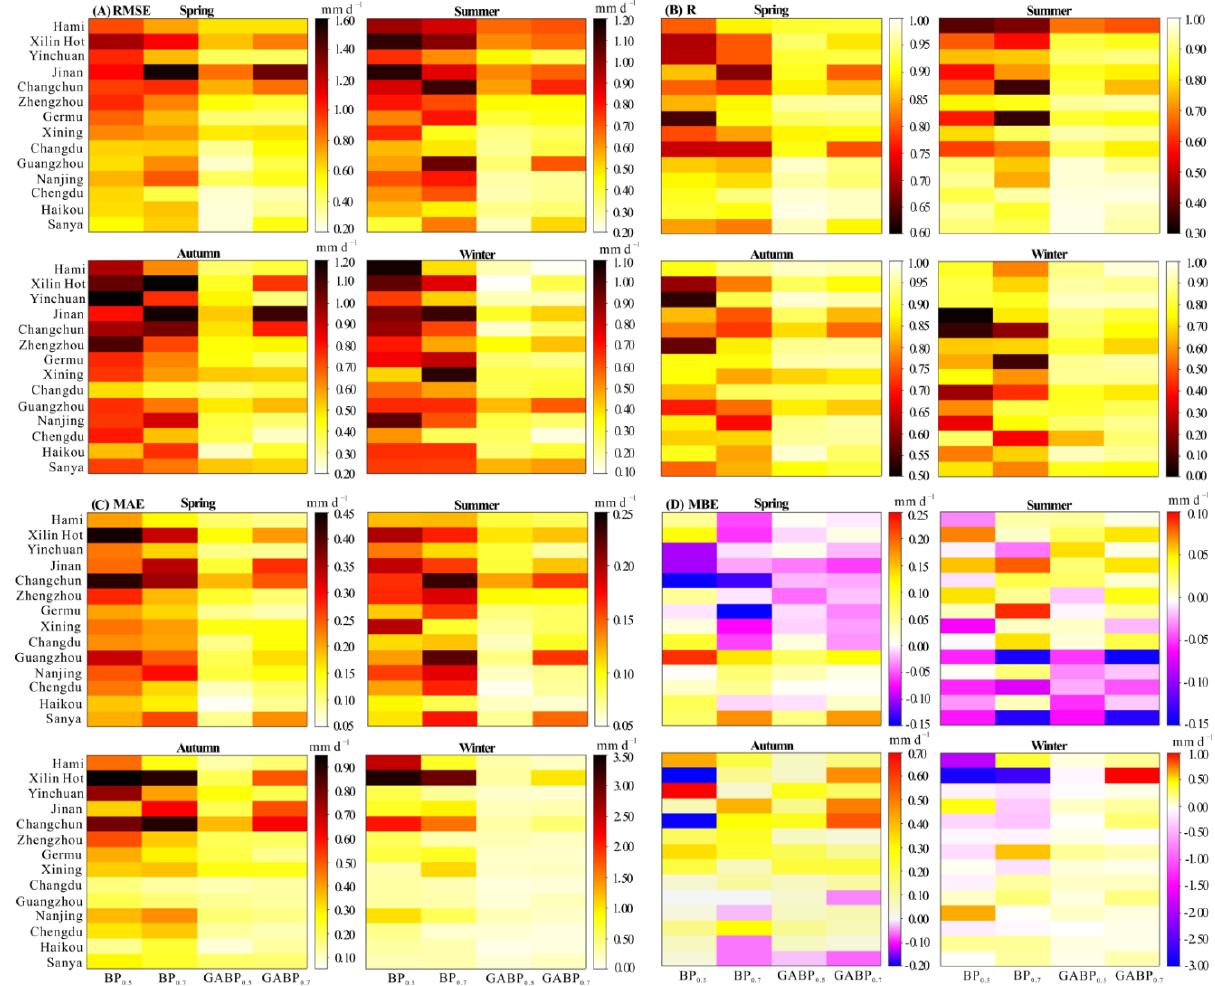
Figure 4. ET 0 estimation performance in testing phase as indicated by ( A ) root mean square error (RMSE), ( B ) correlation coefficient (R), ( C ) mean absolute error (MAE) and ( D ) mean bias error (MBE) of BP 0.5 , BP 0.7 , GABP 0.5 , GABP 0.7 models for the 14 national meteorological stations.